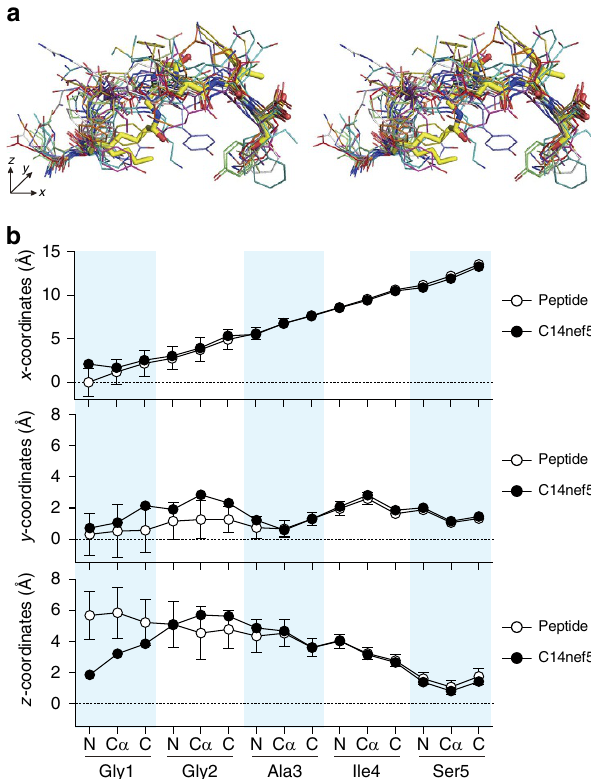
Figure 5 | Spatial configuration of MHC class I-presented C14nef5 and conventional peptides. ( a ) A stereo view of C14nef5 (thick yellow sticks) bound to Mamu-B*098 overlaid with an array of representative 9-mer peptides (thin lines) bound to MHC class I molecules is shown. ( b ) The space coordinates of the main chain of MHC class I-bound peptides were determined for 280 registered MHC class I:peptide complexes and the mean values on the x axis (parallel to two a -helixes), y axis (vertical to the x axis and parallel to the line connecting the centres of two a -helixes) and z axis (vertical to the x axis and y axis) are shown with open circles. Error bars indicate s.d. The space coordinates of Mamu-B*098-bound C14nef5 were also determined and are shown with closed circles. It is worth noting that the three C-terminal residues (Ala3, Ile4 and Ser5) of C14nef5 and corresponding amino acid residues of conventional peptides exhibited a similar spatial configuration, whereas the two N-terminal residues (Gly1 and Gly2) of C14nef5 deviated in the y - and z axes from the position of the corresponding residues of conventional